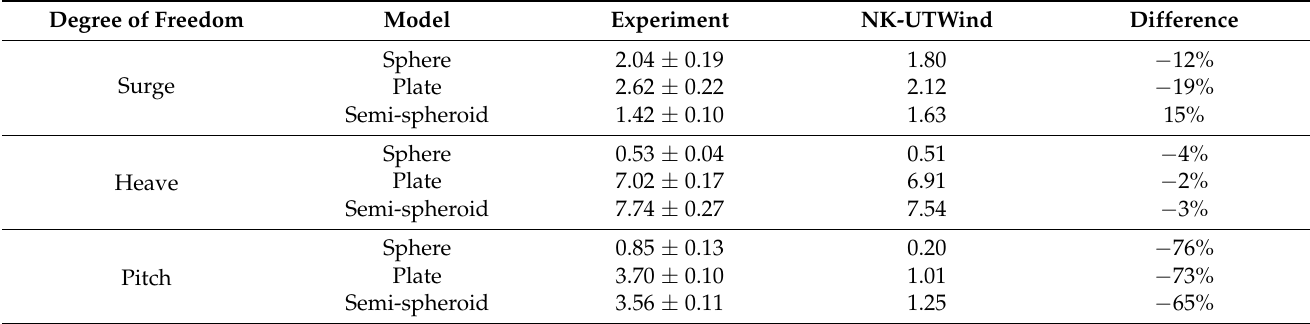
Table 7. Quadratic damping coefficients obtained from free decay tests, b 2 / M , assuming ζ =